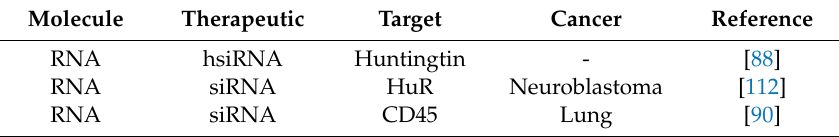
Table 3. Therapeutics conjugated to EV surface and their targets in